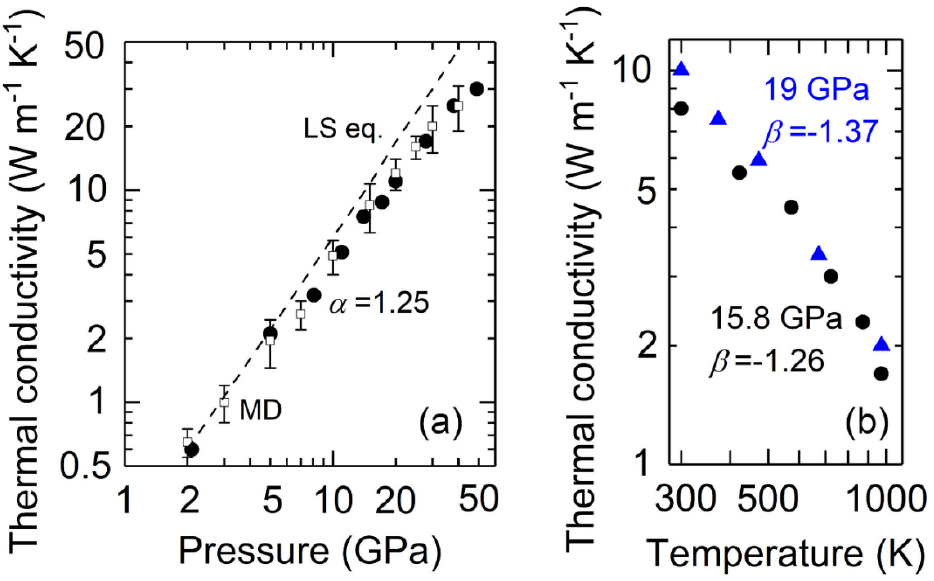
Figure 2. Thermal conductivity of Ar at ( a ) high pressure, room temperature conditions and ( b ) high pressure–temperature conditions. At room temperature, the thermal conductivity (solid circles) increases with pressure with a slope α = 1.25(±0.025) in the ln Λ –ln P plot. The open squares and dashed line in ( a ) are results from Green-Kubo molecular dynamics (MD) simulations [24] and the LS equation. Upon heating, the thermal conductivity decreases with temperature following a dependence of T β , where β = − 1.26(±0.01) and − 1.37(±0.005) at 15.8 GPa (black circles) and 19 GPa (blue triangles), respectively.